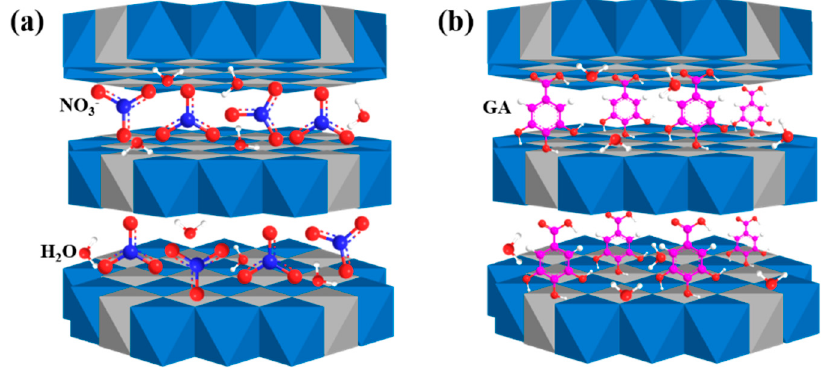
Figure 1. Schematic diagrams of the structure of ( a ) LDH and ( b )